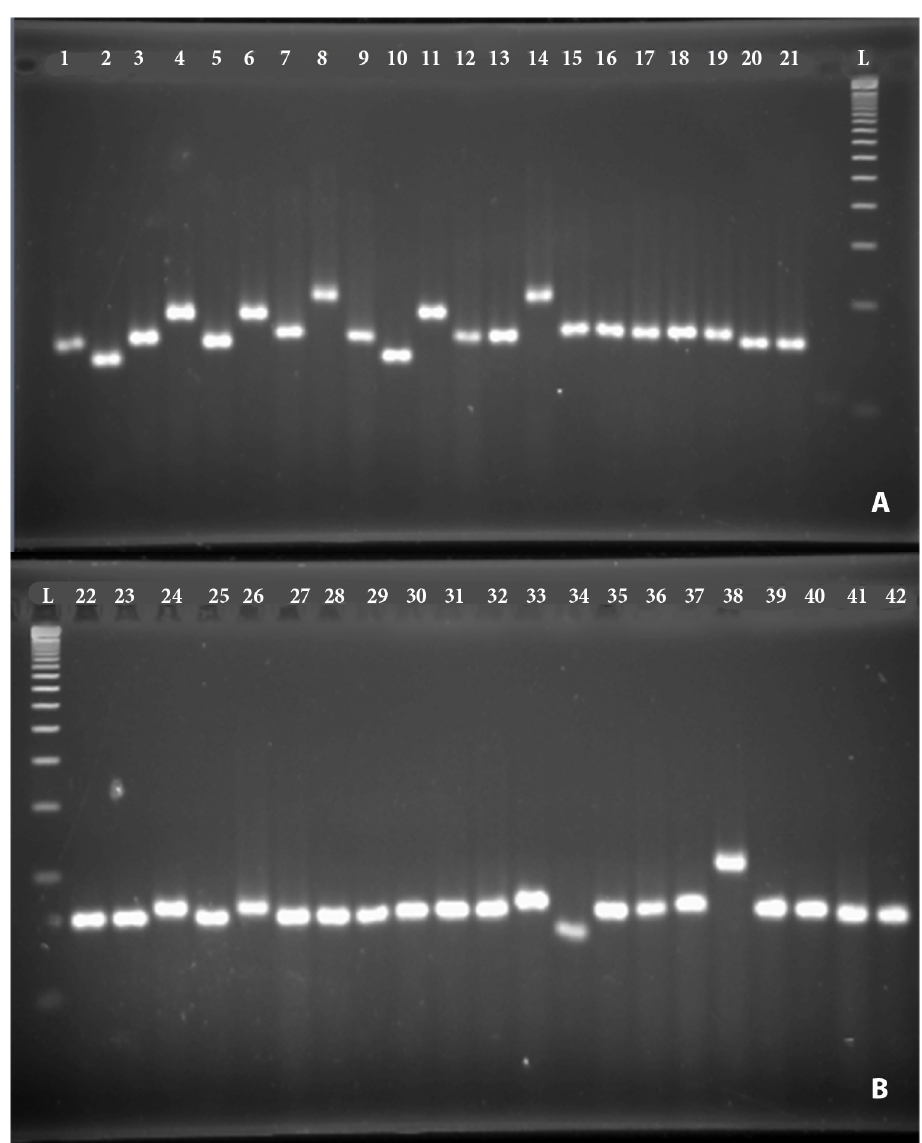
Fig 1. Polymorphic band for marker RM 413 among 42